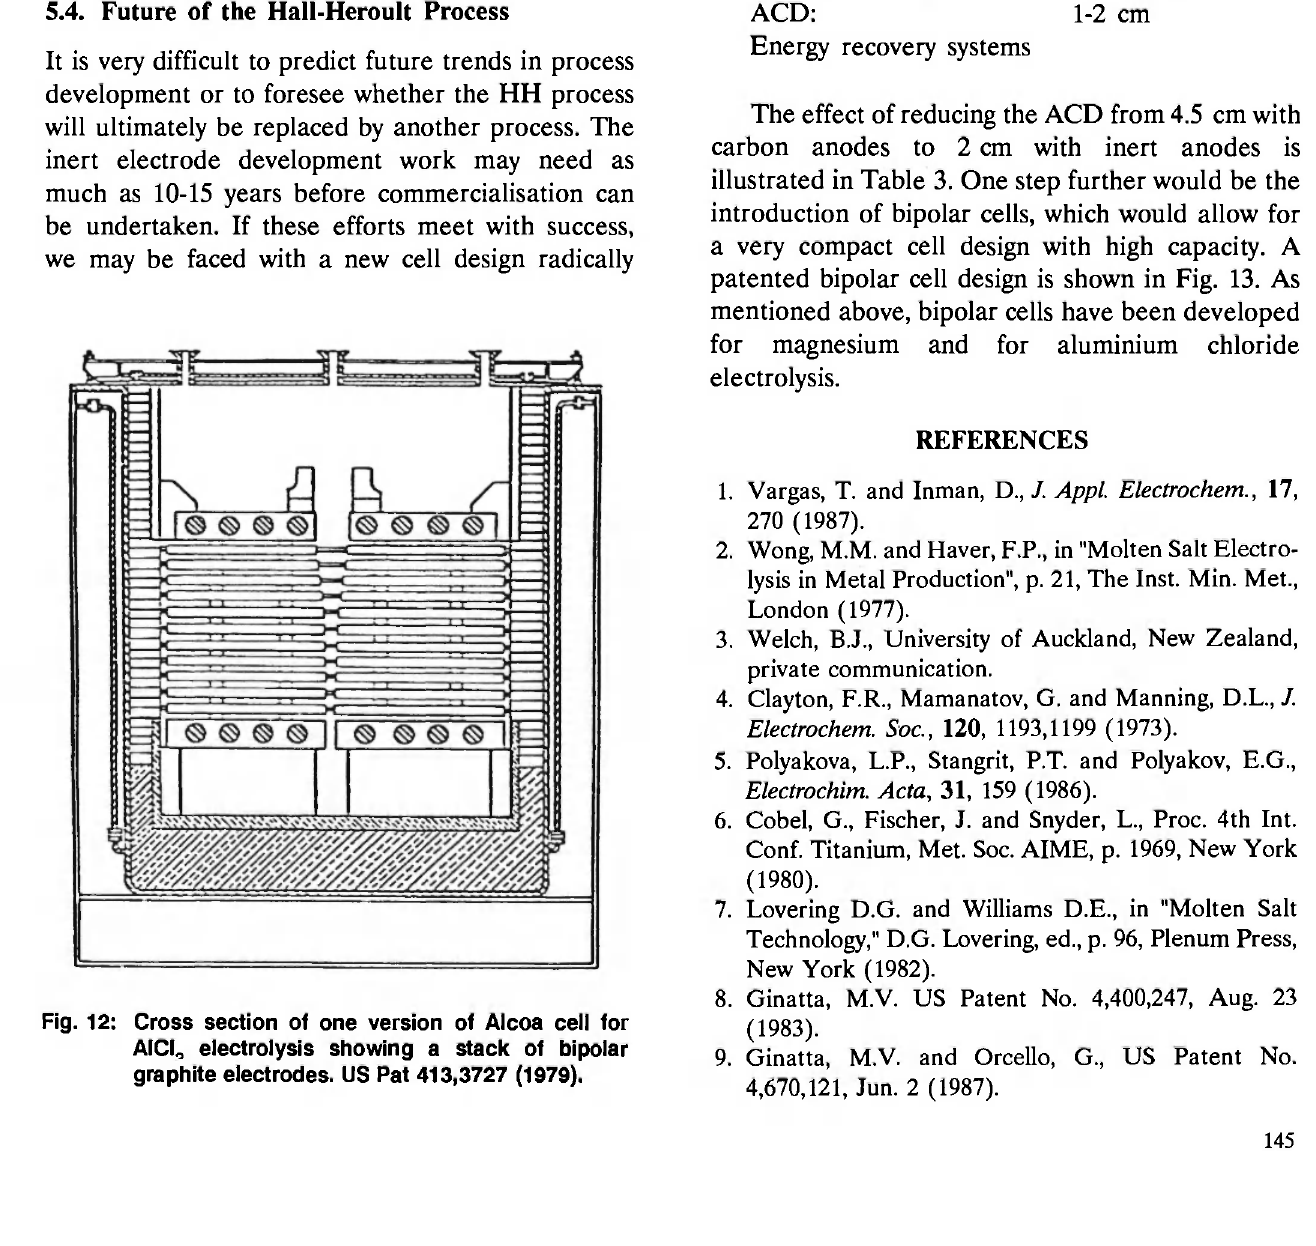
Fig. 12: Cross section of one version of Alcoa cell for AICI, electrolysis showing a stack of bipolar graphite electrodes. US Pat 413,3727 (1979).